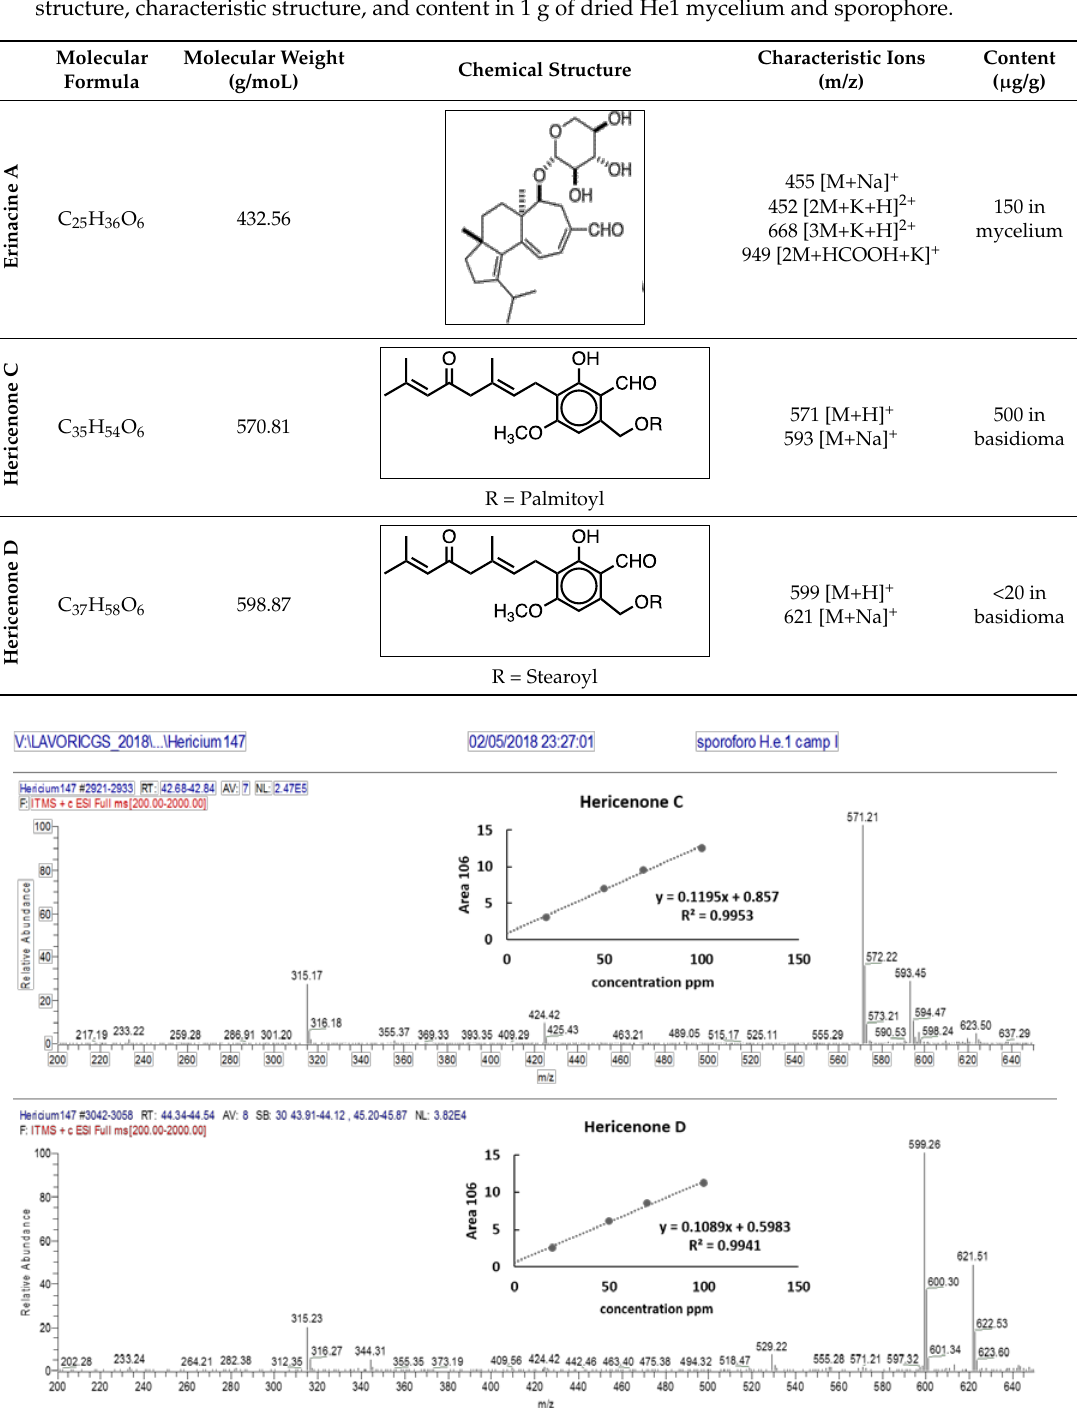
Figure 5. ESI/MS spectra of Hericenone C and D. Panels (top, right) report calibration curves for Hericenone C and D.